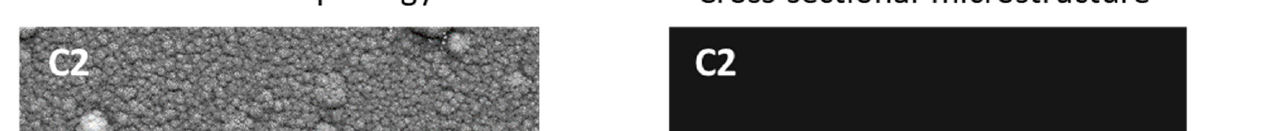
Figure 2. Surface morphology and cross-sectional microstructure of ( a , b ) C2, ( c , d ) C4 and ( e , f ) C6 .